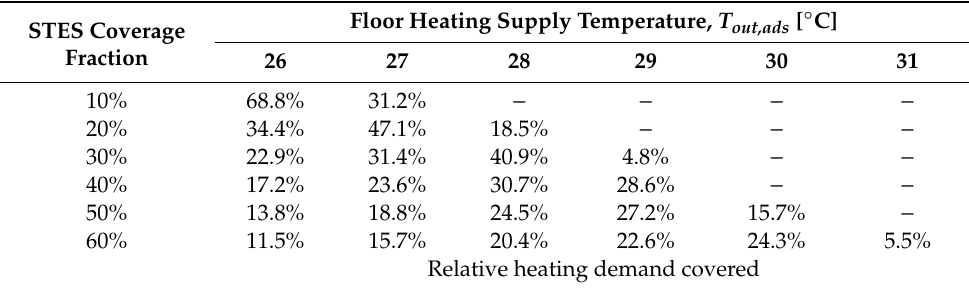
Table 3. Defined space heating supply temperatures for di ff erent STES coverage fraction coverage in Stockholm.